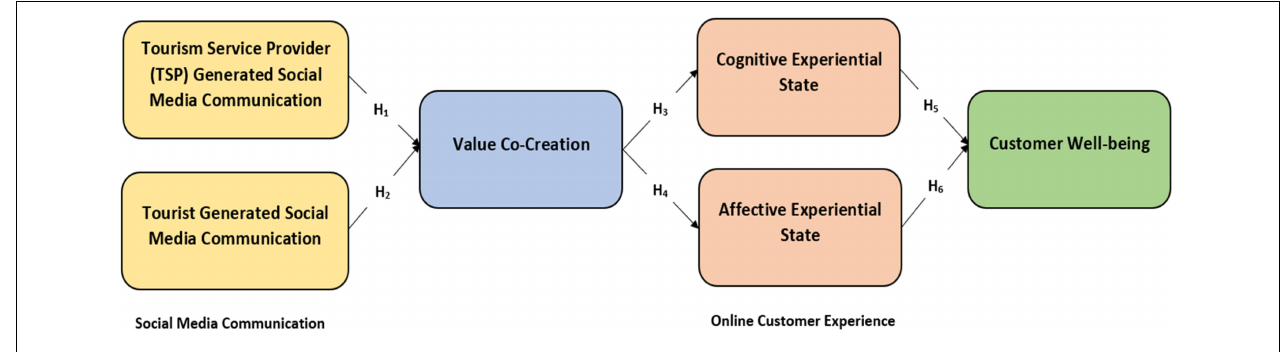
FIGURE 1 | Proposed